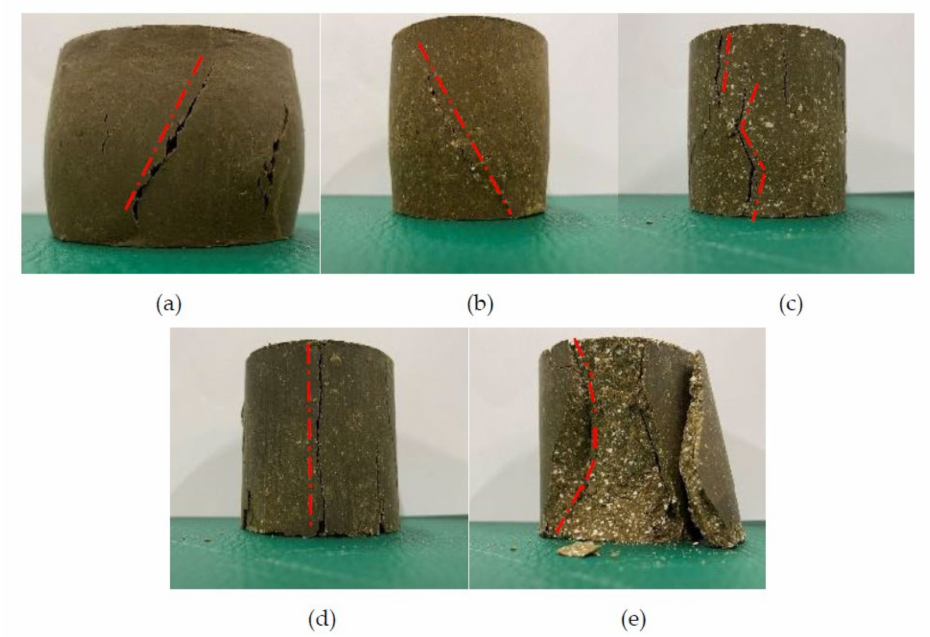
Figure 4. Failure modes of different groups of geopolymer-improved soil: ( a ) untreated soil; ( b ) M6A8; ( c ) M8A8; ( d ) M10A8; ( e )